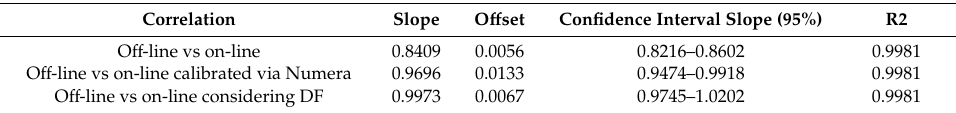
Table 1. Parameters of the correlations between o ff -line and on-line measured samples, (i) applying common calibration of the HPLC, (ii) processing calibration standards via Numera or (iii) adjusting the analytical result by multiplying with the calculated